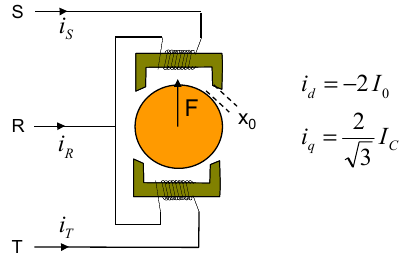
Figure 5. Control strategy with one three-phase inverter provides control current I C and bias current I 0 .